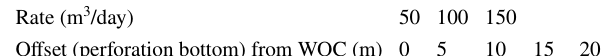
Fig. 5 History match results Table 2 Sensitivity parameters for vertical well